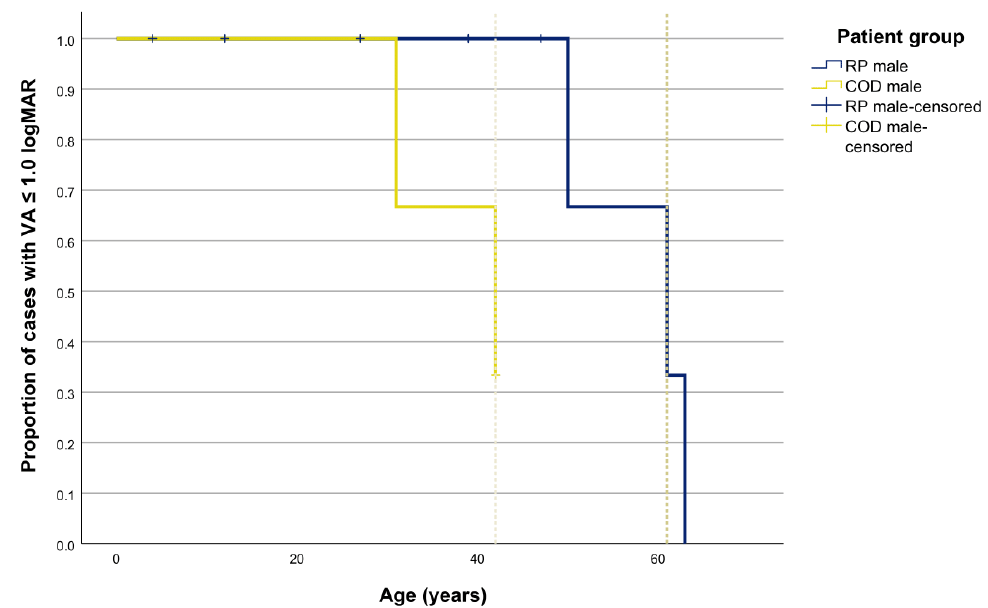
Figure 14. Microperimetry of the COD patients superimposed over corresponding 55° FAF images. Retinal sensitivity map of 56 tested loci in projected around the fixation points. Patient F10P17 was still fixated with the fovea, which indicated the presence of residual photoreceptors in that area, while patients F9P16 and F10P18 shifted the fixation outside the central lesion.